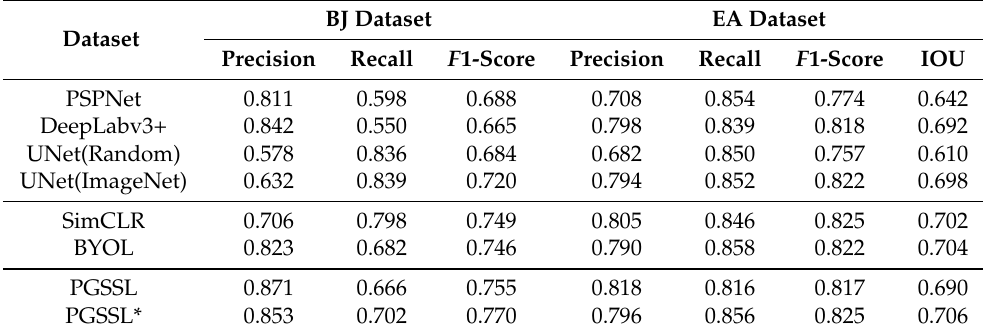
Table 3. Overall experimental effect comparison of all methods. Dataset